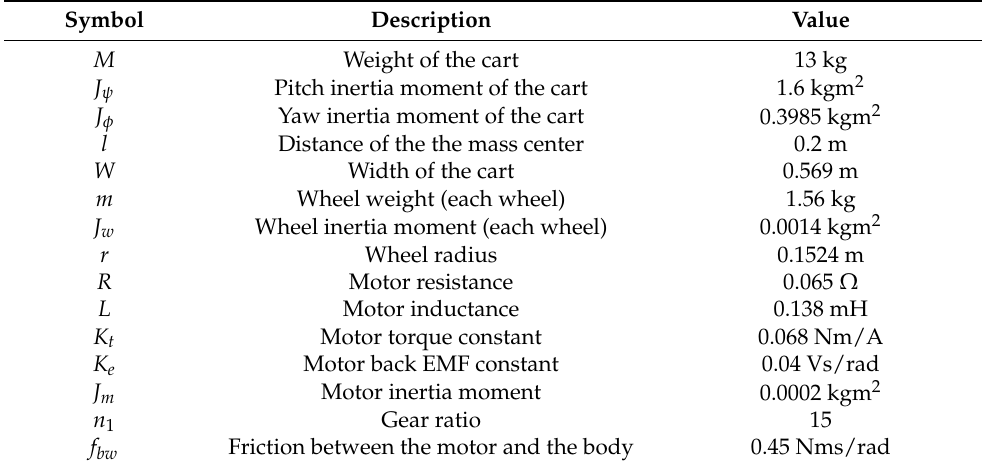
Table 1. Specifications of the TWIP system.